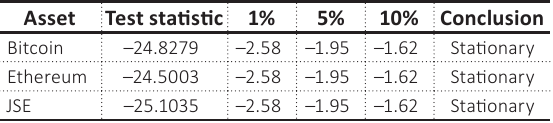
Table 2. Stationarity tests for the returns